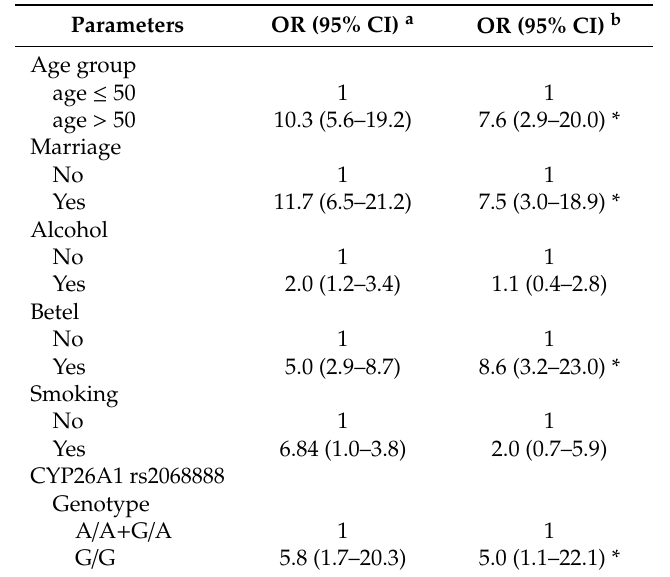
Table 2. Risk factors of oral and pharyngeal cancers for environmental parameters and genetic variant.